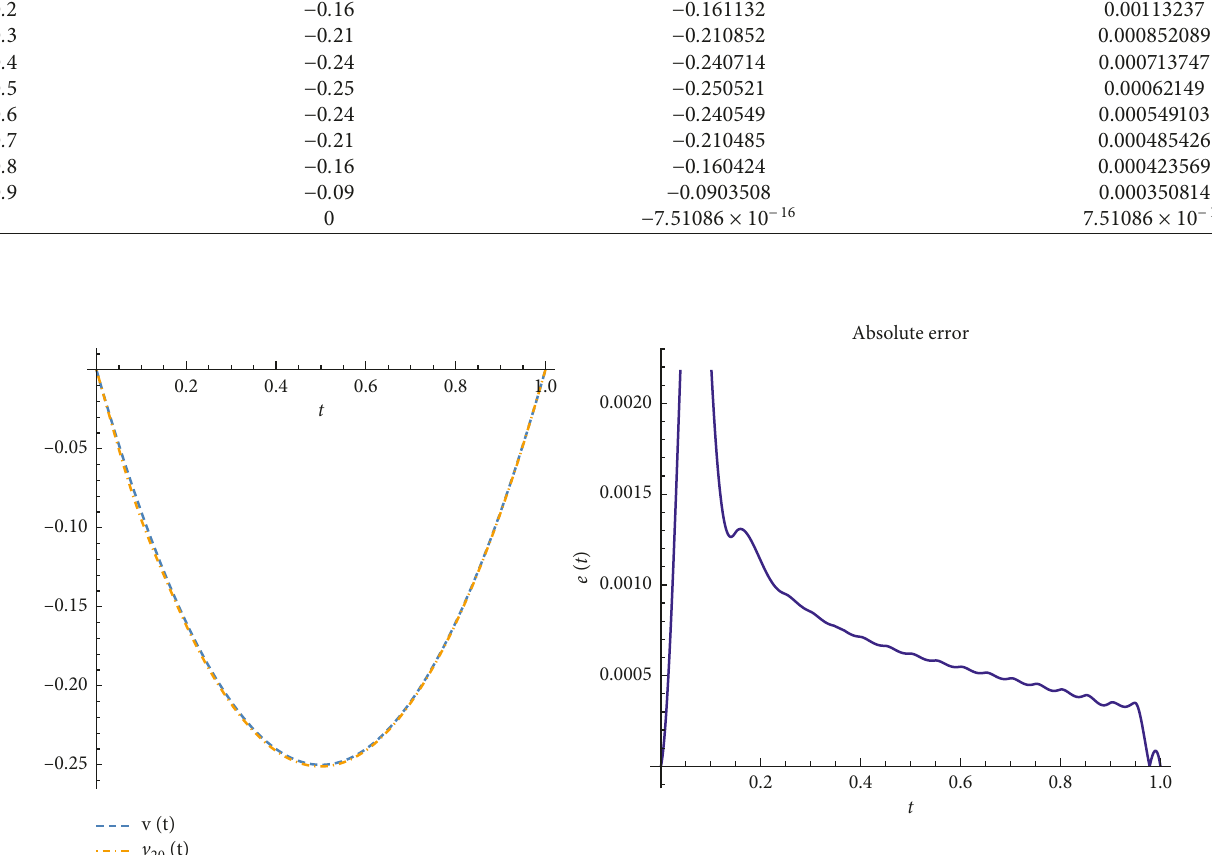
Figure 2: Graphs of numerical solution and absolute error with n � 20 for Example 2.